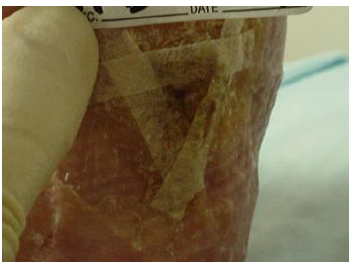
Figure 8. Appearance of wound at week 12, after re-application of bi-layered living skin equivalent.